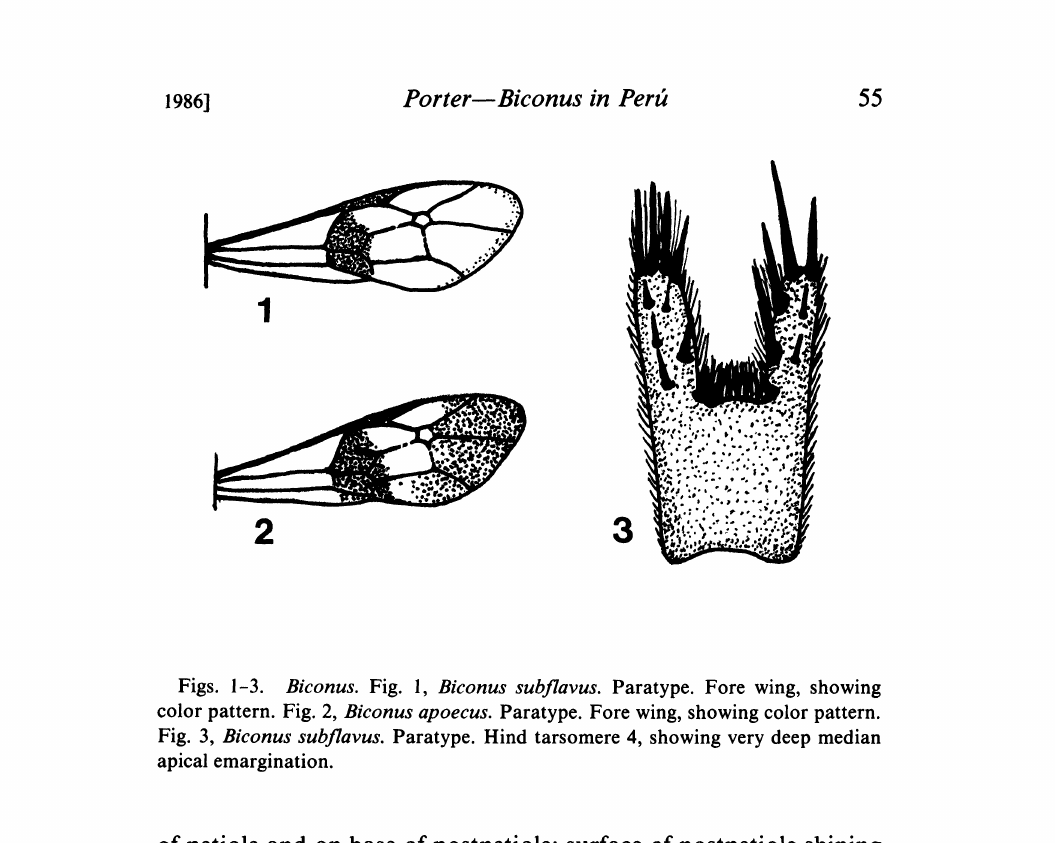
Figs. 1-3. Biconus. Fig. 1, Biconus subflavus. Paratype. Fore wing, showing color pattern. Fig. 2, Biconus apoecus. Paratype. Fore wing, showing color pattern. Fig. 3, Biconus subflavus. Paratype. Hind tarsomere 4, showing very deep median apical